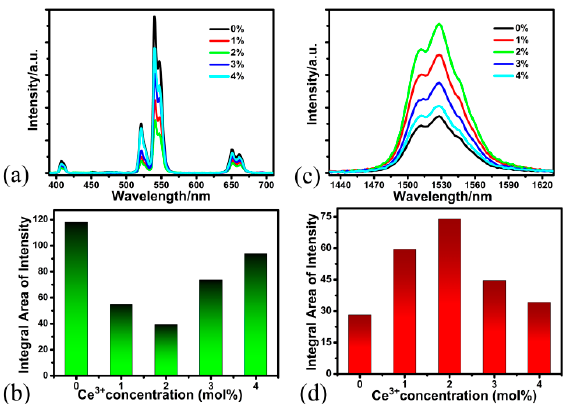
Figure 4. ( a ) UC and ( c ) DC emission spectra of BaLuF 5 :18%Yb 3+ ,2%Er 3+ , x % Ce 3+ NPs with different Ce 3+ concentrations ( x = 0, 1, 2, 3, and 4) under the excitation of a 980 nm laser diode. Intensity enhancement of ( b ) UC and ( d ) DC emission depending on the Ce 3+ concentrations in BaLuF 5 :18%Yb 3+ ,2%Er 3+ , x %Ce 3+ NPs.